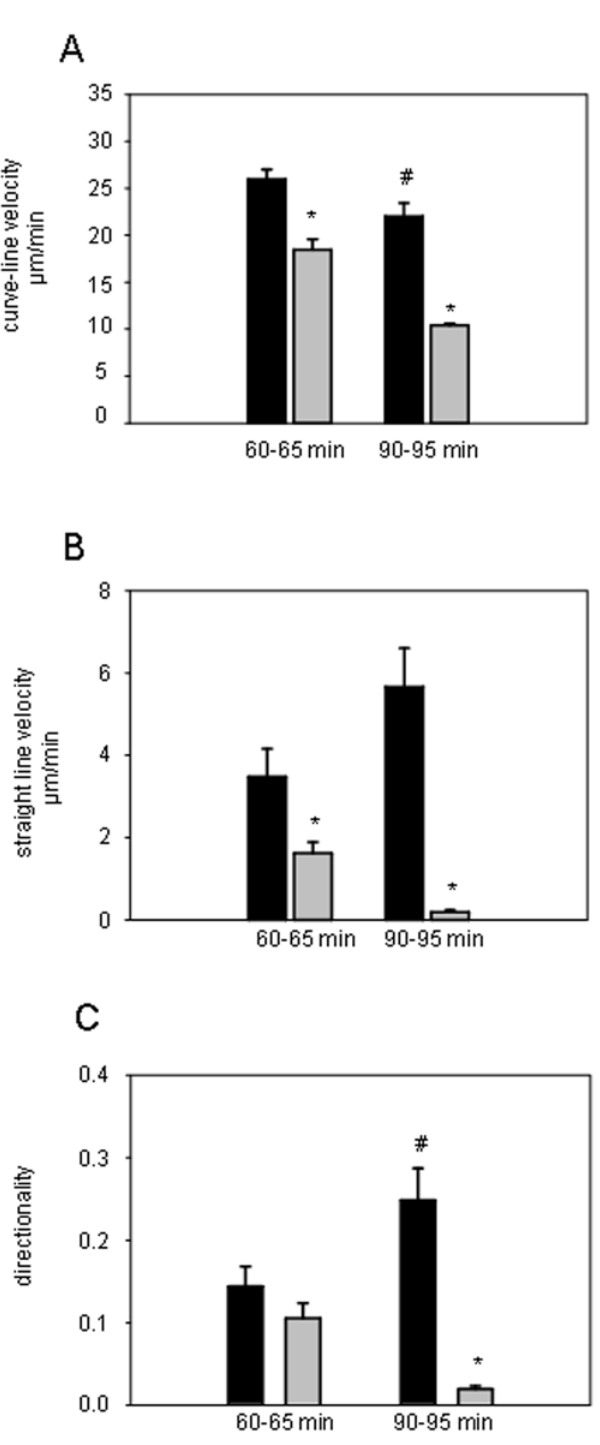
Figure 6. Effect of Rho kinase inhibition on leukocyte motility. Leukocyte curve-line velocity (A), straight-line velocity (B), and directionality (C) were analyzed in the cremaster muscle at 60 min after microinjection of MIP-1 a (black bars) followed by superfusion of the Rho kinase inhibitor Y27632 (gray bars) for either 0–5 min or 30– 35 min. In control experiments (black bars), the cremaster muscle was superfused with saline upon microinjection of MIP-1 a ; mean 6 SEM; *p , 0.05 vs. control, # p , 0.05 vs. control at 60–65 min; n=15.